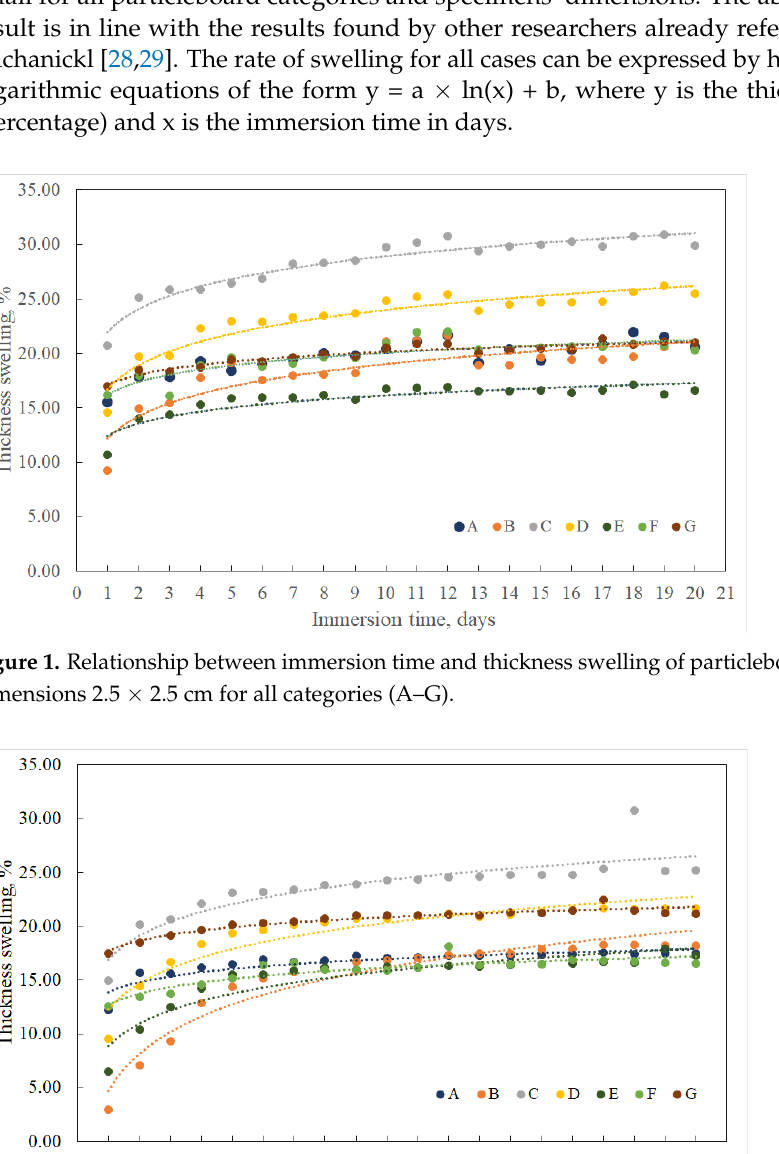
Figure 3. Relationship between immersion time and thickness swelling of particleboard samples with dimensions 10.0 × 10.0 cm for all categories (A–G). From Figures 2 and 3, it can be found that the differences between the ten and twenty- day immersions are small and lower than 3.5%. For practical reasons, the thickness swell- ing after the ten-day immersion can be preferred instead of that after the twenty-day im- mersion. The small differences in the water absorption between the 10 and 20-day immer- sion also support this preference. Water absorption ranged between 77.23% and 100.58% for the 10-day immersion, and between 84.08 and 107.50% for the 20-day immersion. Such pretreatment of particleboard samples by their immersion in cold water up to a level of water absorption of 60% was used by Lykidis [15] in order to facilitate the disintegration of samples by hydrothermal treatments. Additionally, Figure 3 includes the permanent thickness swelling after the period of the twenty-day immersion and air drying as well as the corresponding water absorption after ten and twenty days of immersion. This perma- nent swelling ranged between 1/4 and 1/2 of the thickness swelling of the twenty-day im- mersion. This size of permanent swelling indicates that after the pretreatment used in the present work, the bond between the wood particles was reduced but not to a satisfying degree in order to achieve better disintegration and the chips’ recovery.